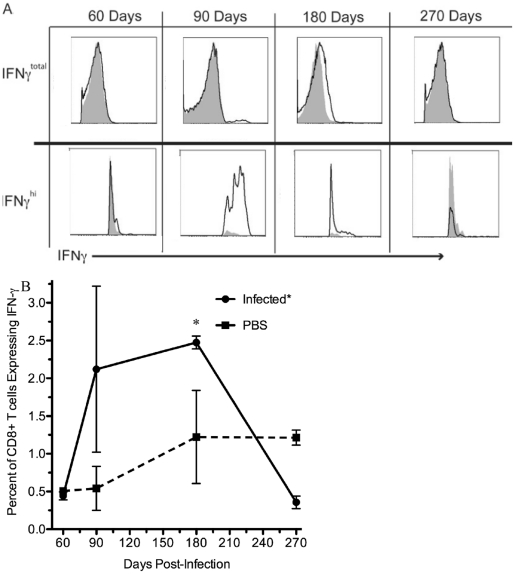
CD8+ T cell IFN-γ expression.A) Histograms of IFN-γ staining over time. Note the top row shows the total IFN-γ expression while the bottom row examines the subtle differences of IFN-γhi expression between uninfected and infected mice. The black line represents splenocytes from infected mouse pulsed with B. melitensis specific peptide. The shaded grey region represents splenocytes from an uninfected age-matched mouse pulsed with B. melitensis specific peptide. B) Percent of CD8+ T cells expressing IFN-γ in infected and non-infected mice. *p<0.05.